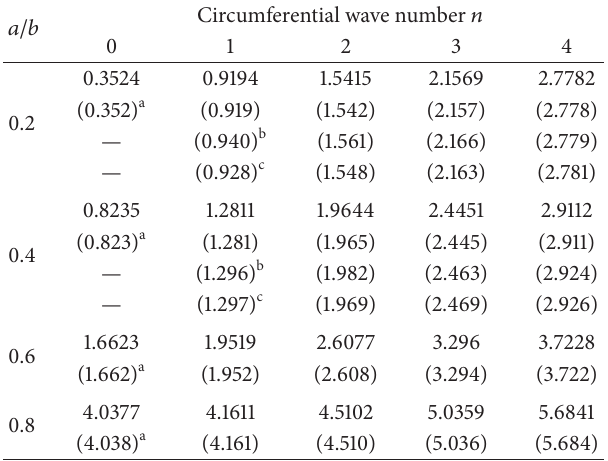
Table 5: Frequency parameters, Ω = 𝜔𝑏(𝜌(1 − V 2 )/𝐸) 1/2 , for F-C annular plates with various cutout